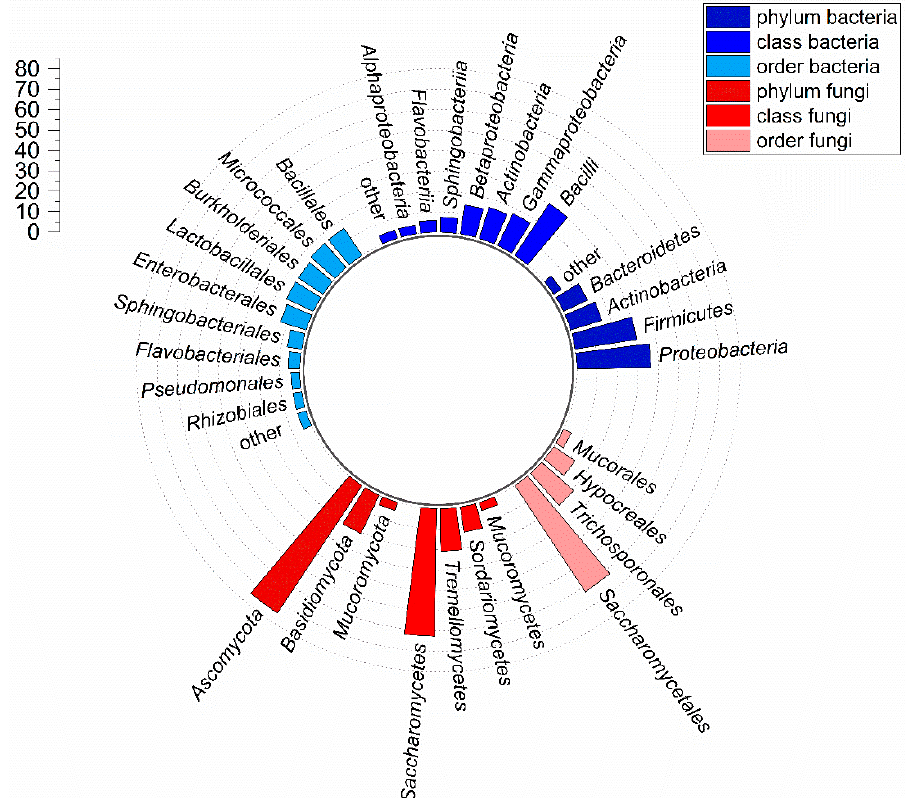
Figure 2. Radial bar plot of the cultivable gut microbiota composition. The proportion of bacterial and fungal phyla, classes and orders were grouped and compared. Dashed lines indicate 10% intervals. Isolates that could not be assigned to a specific taxon were summarized as ‘others’.